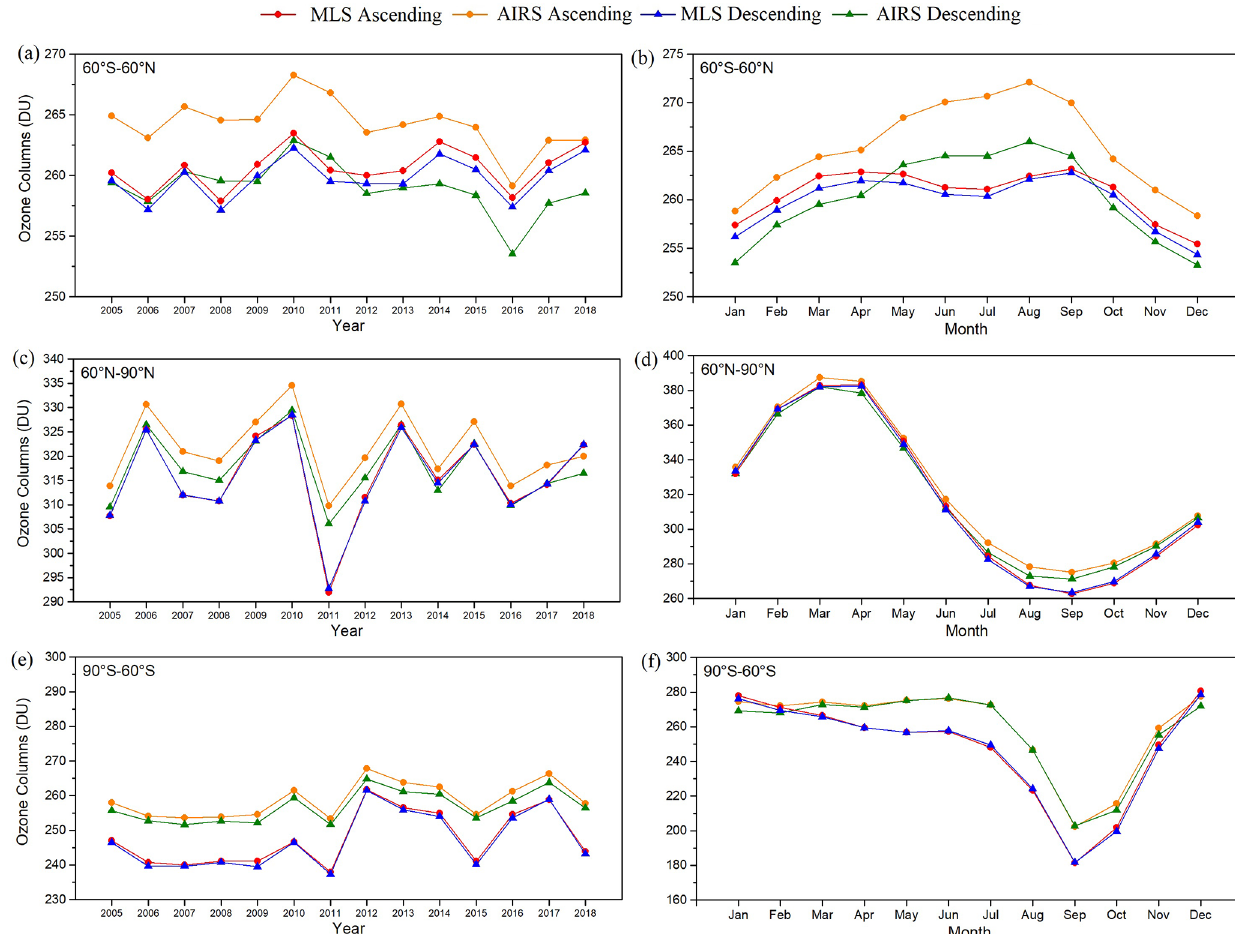
Figure 5. Yearly and monthly averaged AIRS SCO and MLS SCO for 2005–2018. AIRS SCOs are calculated from 250 to